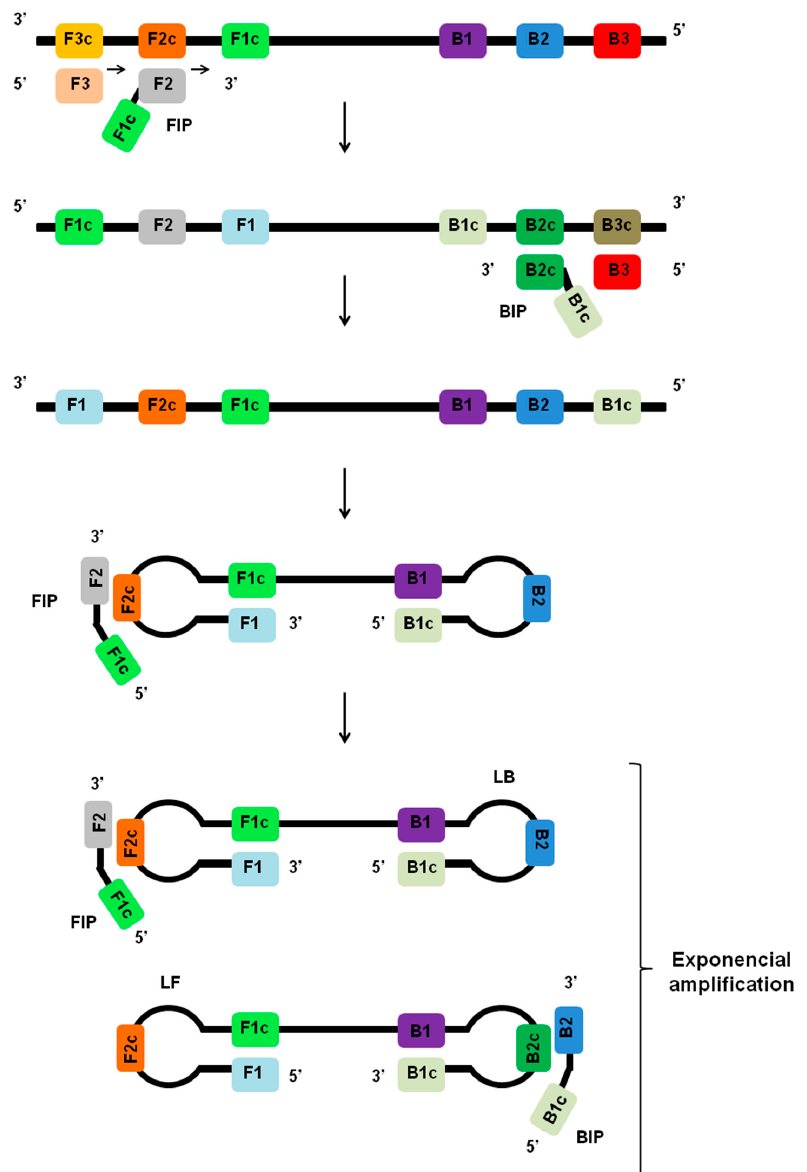
Figure 1. Principles of LAMP assay. During the initial stages of the LAMP reaction, the inner primers (FIP or BIP) anneal to regions F2c or B2c within the target region. The LAMP reaction is initiated by strand invasion by the inner primers, and a strand displacement DNA polymerase extends the primer and separates the target DNA duplex. The outer primers (F3 or B3) then hybridizes to region F3c or B3c on the target and initiates the formation of self-hybridizing loop structures by the strand invasion. This results in the formation of a dumbbell-shaped DNA, which becomes a seed for exponential amplification. As a result of this process, various sized structures consisting of stem-loop DNA with various stem lengths and various cauliflower-like structures with multiple loops are formed. The addition of loop primers (LF and LB) can accelerate the process.